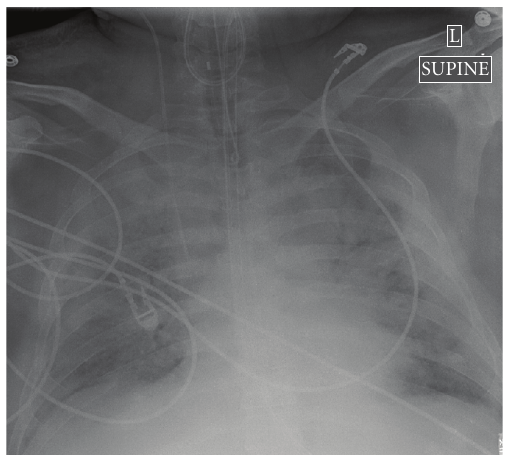
Figure 1: Admission chest X-ray showing severe bilateral di ff use pulmonary